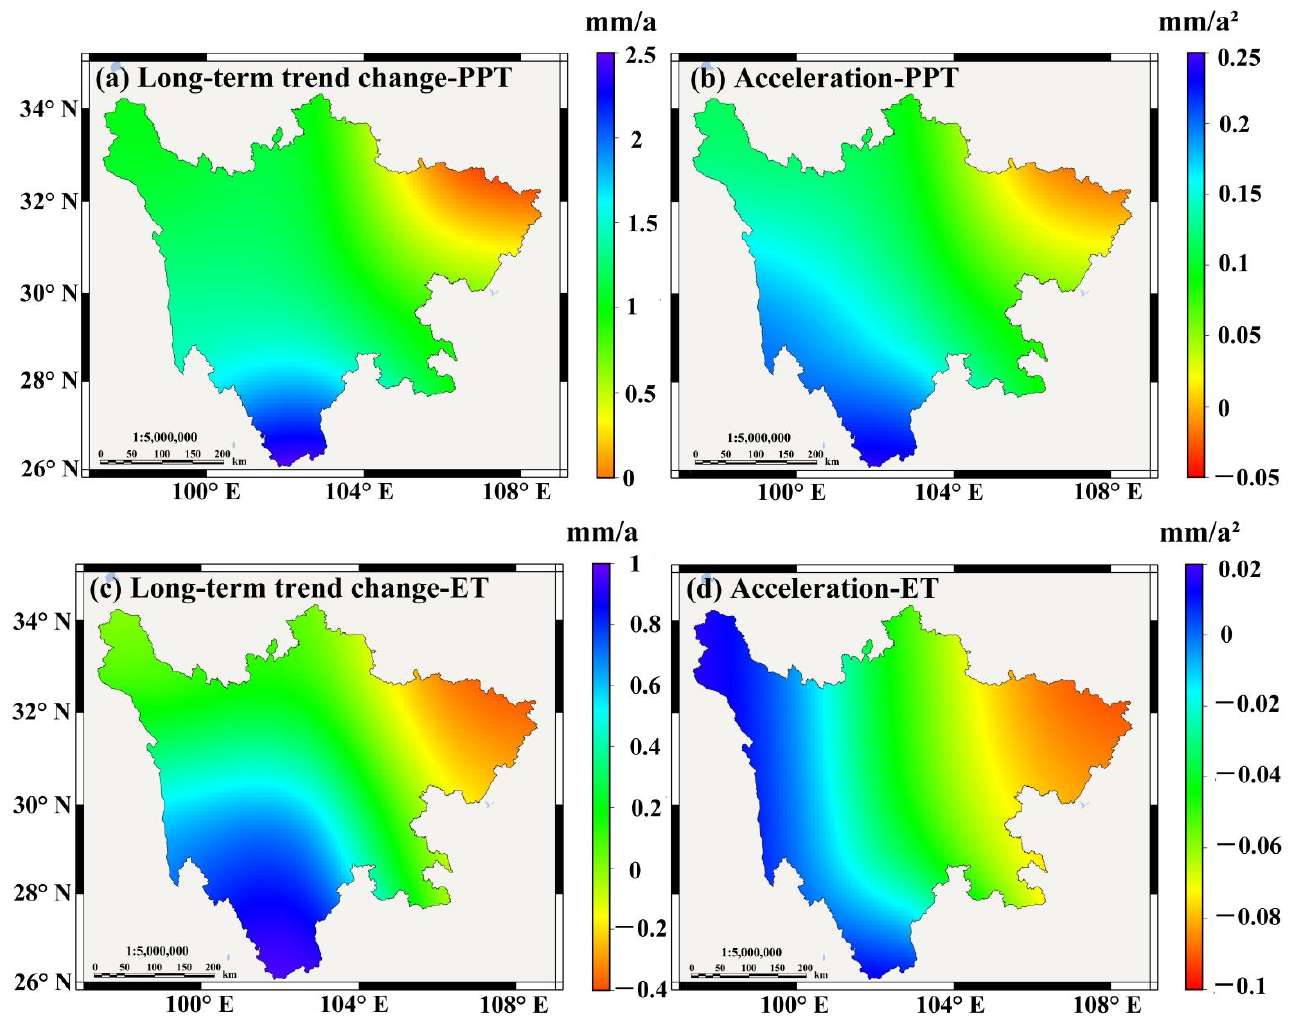
Figure 7. The spatial distribution of long-term trend changes and the acceleration of PPT and ET in Sichuan. ( a ) long-term trend change of PPT; ( b ) acceleration of PPT; ( c ) long-term trend change of ET; ( d ) acceleration of ET.